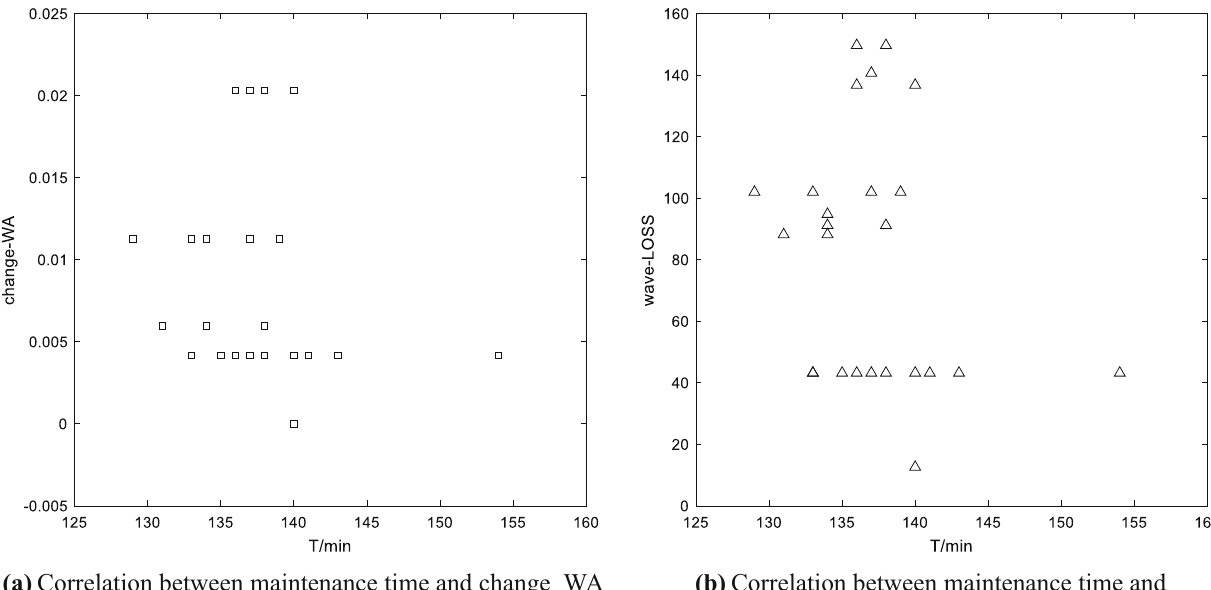
Fig. 20 Correlation between maintenance time and evaluation indexes for 13 carrier-based